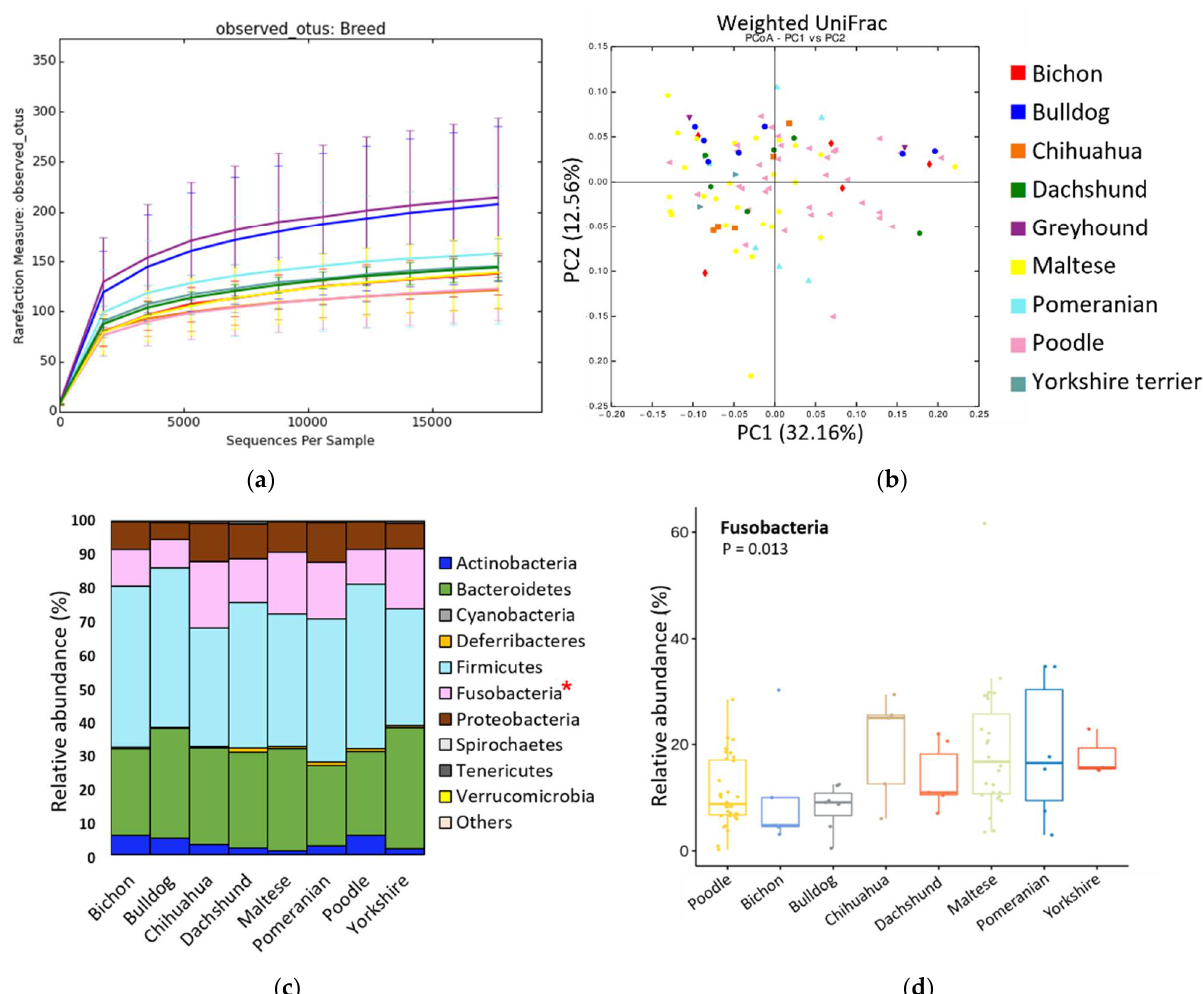
Figure 2. Alpha-, beta diversity, and relative abundances at the phylum level according to breed. ( a ) Microbial richness was measured based on observed OTUs. ( b ) PCoA was performed based on weighted UniFrac distances. ( c ) Relative abundance at the phylum level. ( d ) Box plot of the abundance of Fusobacteria that showed significant differences among breeds. * Indicates that significantly different bacteria group.